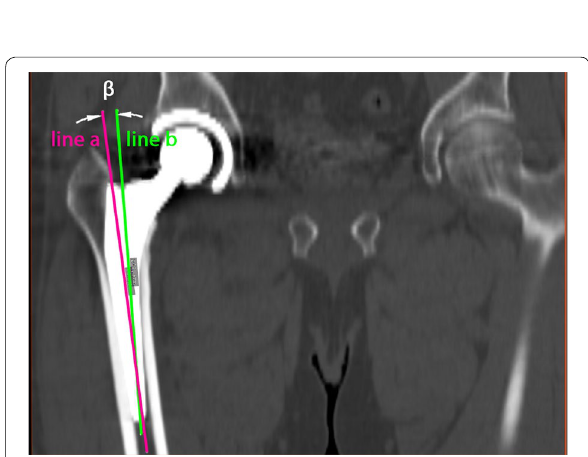
Fig. 3 Measurement of the alignment of the implant in relation to the femoral shaft axis in the coronal plane (varus/valgus). Line a represents the femoral shaft axis, line b the implant shaft axis. In this case the alignment angle β was 5.7° varus